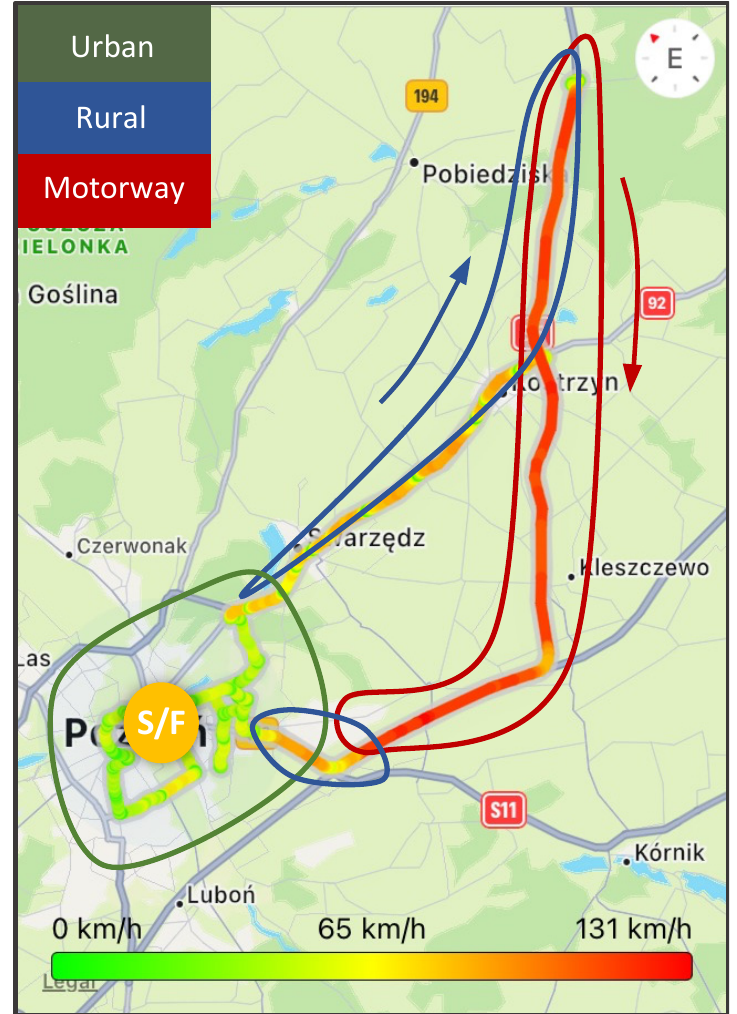
Figure 12. Route divided into particular sections (S\F—Start/Finish).